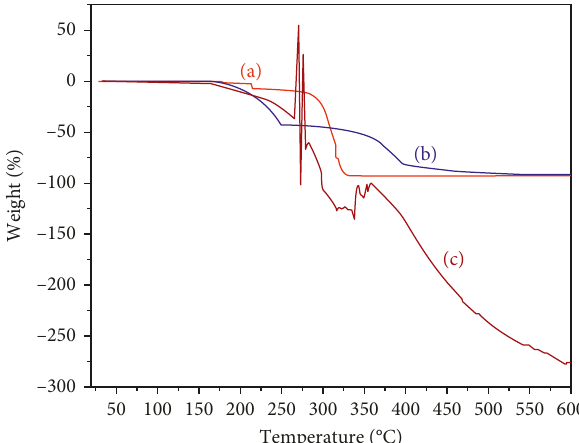
Figure 2: TGA of (a) choline chloride, (b) urea, and (c) choline chloride:urea 1 :1.